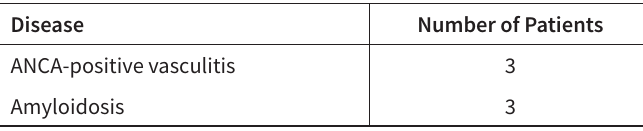
Table 2. Systemic Diseases with Glomerular Involvement in 51 Patients with Nondiabetic Nephropathy Disease Number of Patients ANCA-positive vasculitis 3 Amyloidosis 3 ANCA, antineutrophilic cytoplasmic